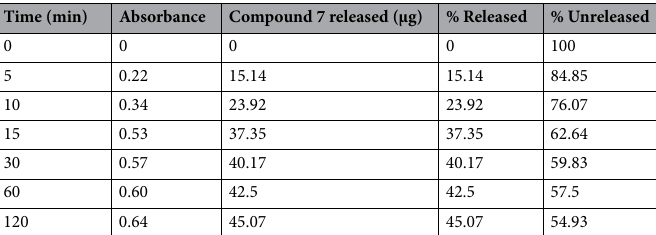
Table 5. Percentage of compound 7 diffuse through Franz diffusion